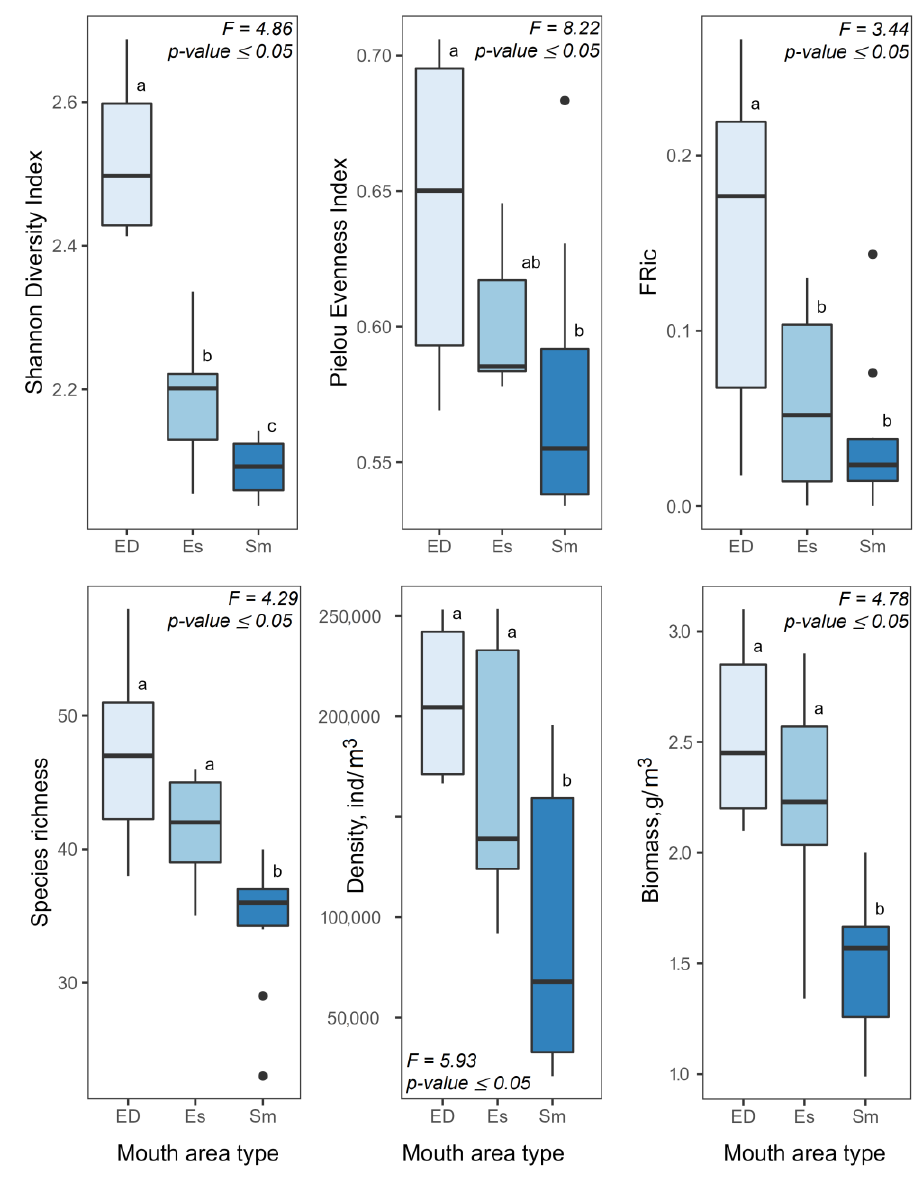
Figure 5. Boxplots of the structural indicators for zooplankton community 2 in the estuary–deltaic mouth areas (ED), estuarine mouth areas (Es), and simple mouth areas (Sm). Compact letter displays were added to indicate significant differences.